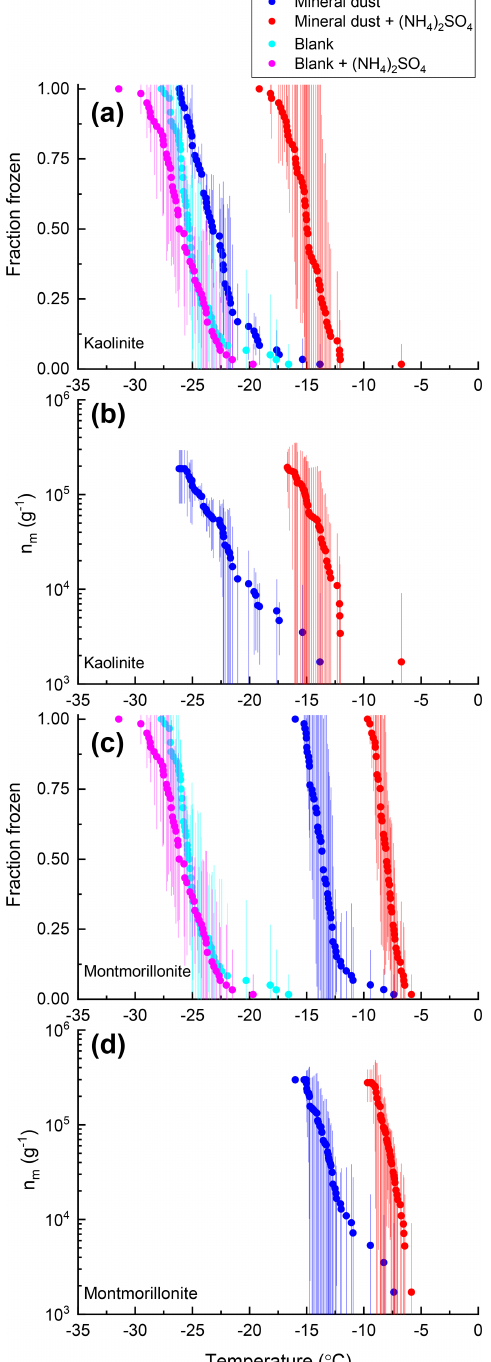
Figure 10. Fraction of droplets frozen (a, c) and ice nucle- ation active site densities n m (T ) (b, d) for samples of kaolinite (a, b) and montmorillonite (c, d) with (red) and without (blue) 0.05M(NH 4 ) 2 SO 4 compared with an ultrapure water blank with (pink) and without (cyan) 0.05M(NH 4 ) 2 SO 4 . Freezing data (both samples and blanks) have been corrected for freezing point depres- sion by 0.05M(NH 4 ) 2 SO 4 . Error bars represent the 95% confi- dence interval of fraction frozen or n m (T ) at temperature T calcu- lated using Student’s t